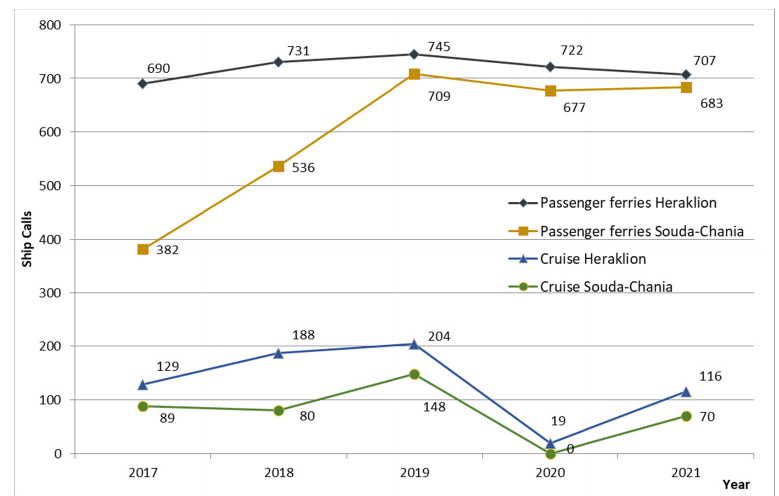
Figure 2. Annual ship calls for ports Souda and Heraklion (years 2017–2021).